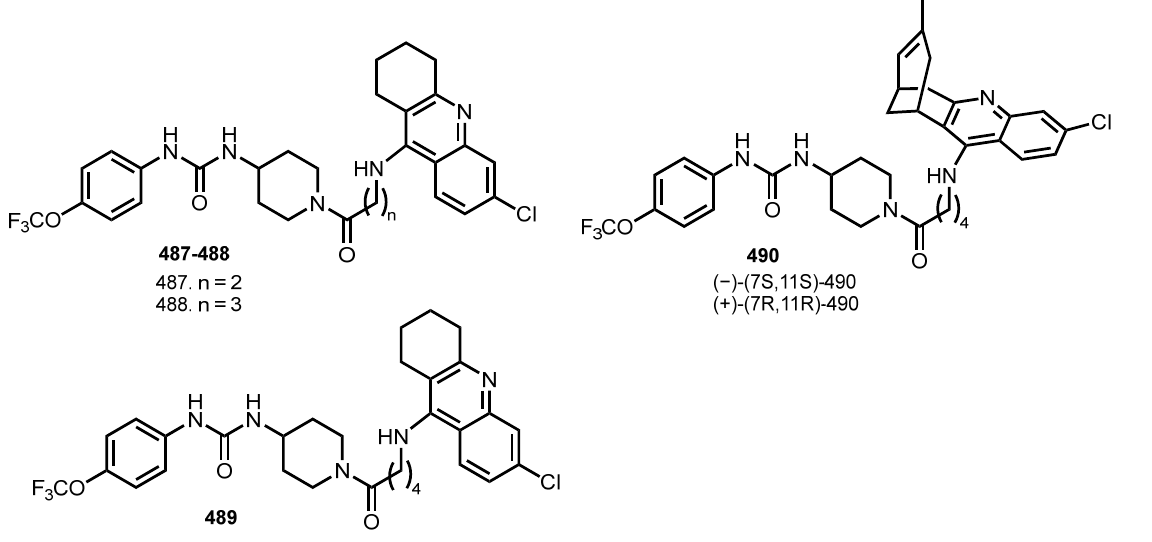
Figure 17. 6 ‐ Cl ‐ THA–TPPU 487 – 489 and huprine–TPPU hybrids ( − ) ‐ (7S,11S) ‐ 490, (+) ‐ (7R,11R) ‐ 490 Figure 17. 6-Cl-THA–TPPU 487 – 489 and huprine–TPPU hybrids ( − )-(7S,11S)-490, (+)-(7R,11R)- [84]. 490